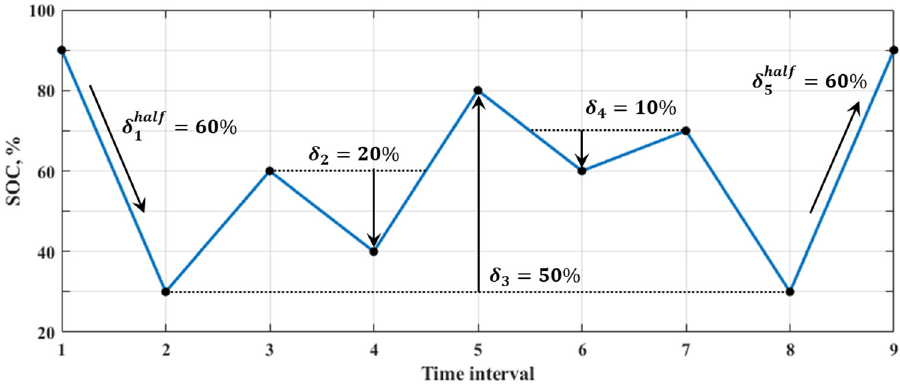
Figure 6. Example of cycle counting using the rainflow algorithm.